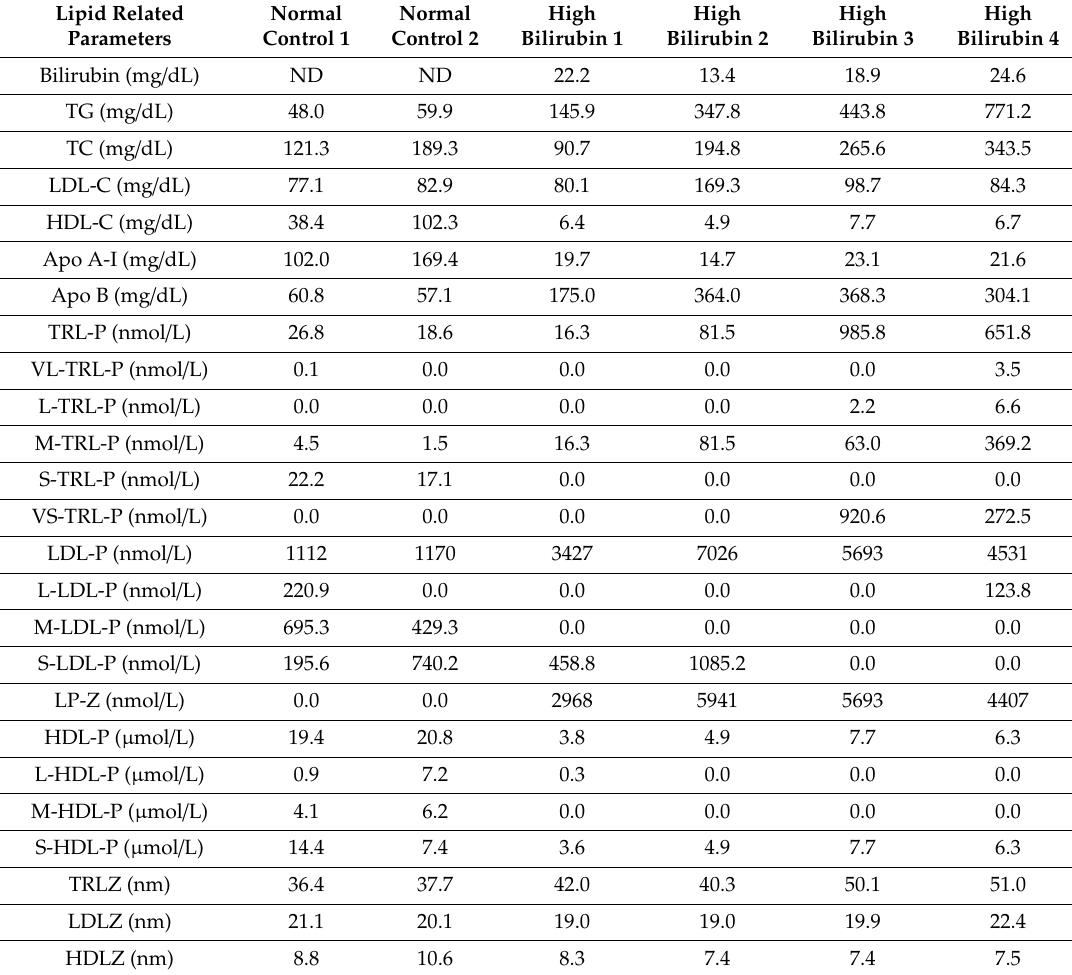
Table 1. Concentrations of NMR-measured lipid and lipoprotein parameters in samples from normal subjects ( n = 2) versus subjects with high bilirubin ( n =